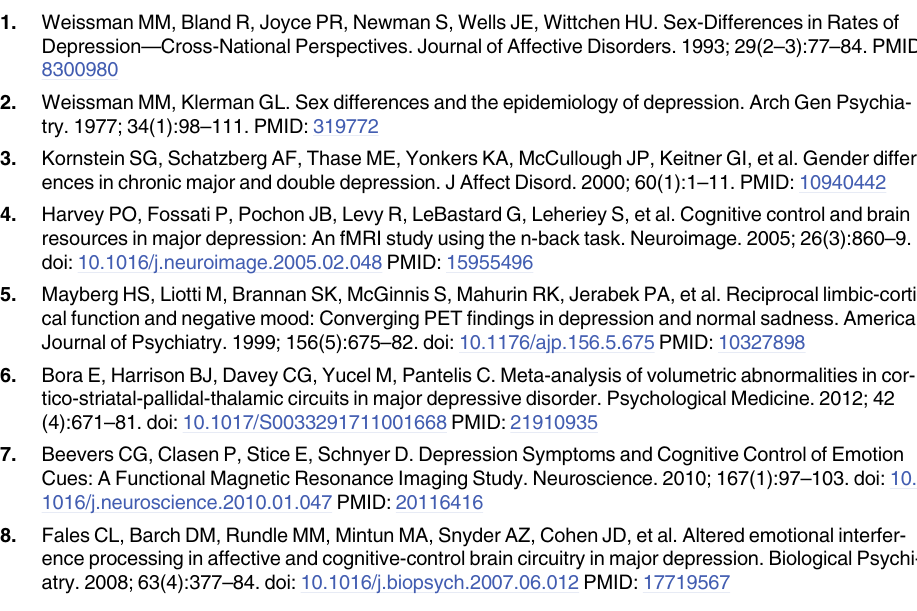
S5 Dataset. T1 structure data (13 healthy controls). (ZIP) S6 Dataset. T1 structure data (6 healthy controls). (ZIP) S7 Dataset. Statistical analysis results.